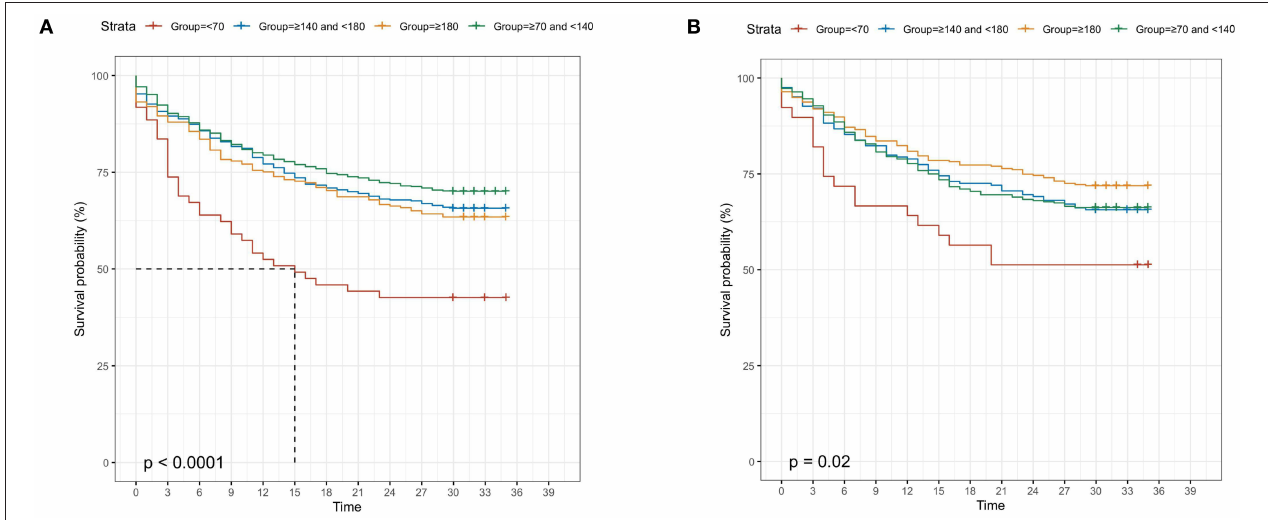
FIGURE 2 | Kaplan-Meier curves for 30-day survival probability in septic patients, according to the admission blood glucose (A) in diabetic patients; (B) in non-diabetic patients.